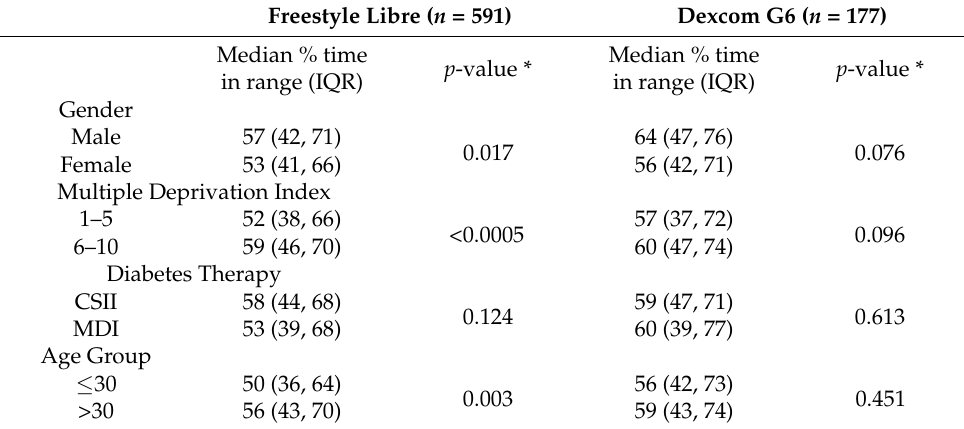
Table 4. Comparison of median time in range (3.9 to 10 mM) by gender, age, multiple deprivation index and diabetes therapy in people with type 1